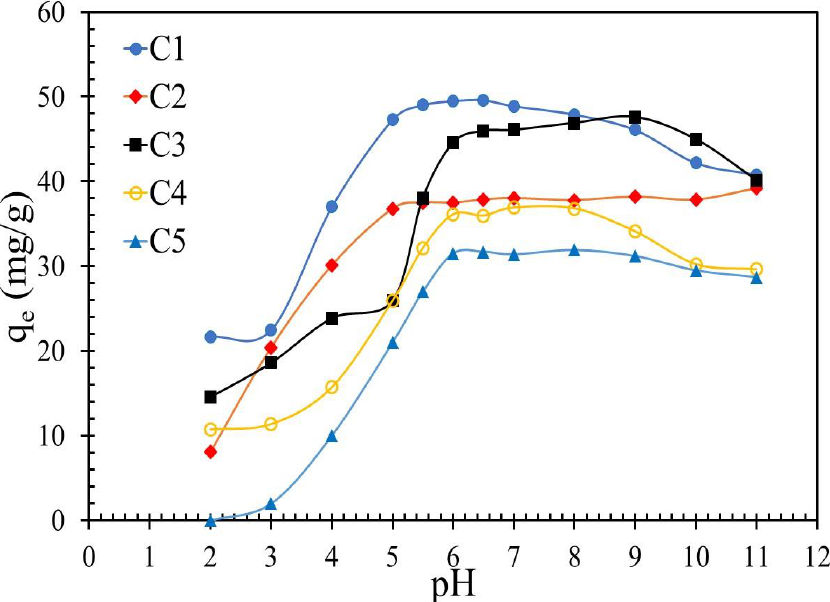
Figure 9. Initial pH effects on the amount (mg/g) of Pb (II) removed by different clays in the study; agitation speed (130 rpm), contact time 6 h, temperature (25 °C) and initial adsorbate concentration (300 mg/L).